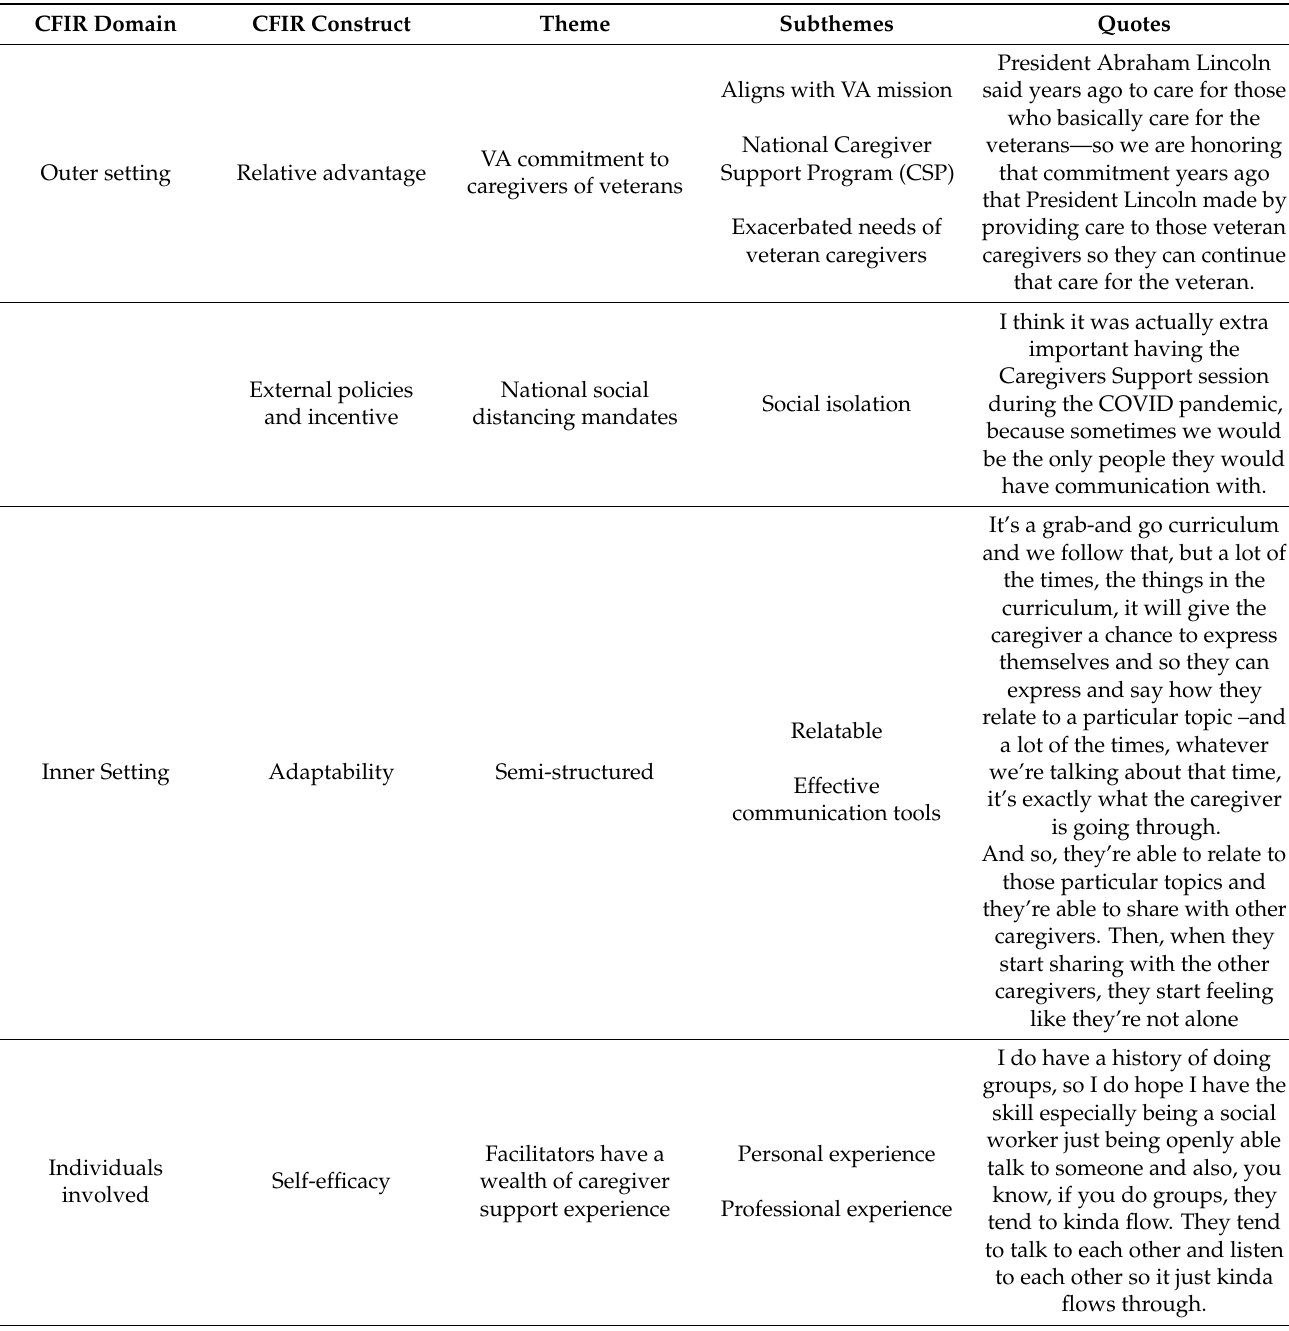
Table 2. Qualitative facilitator themes within CFIR domains and constructs—Caregivers First. CFIR